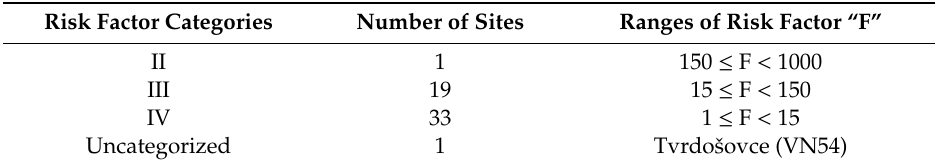
Table 1. Dams by the “risk